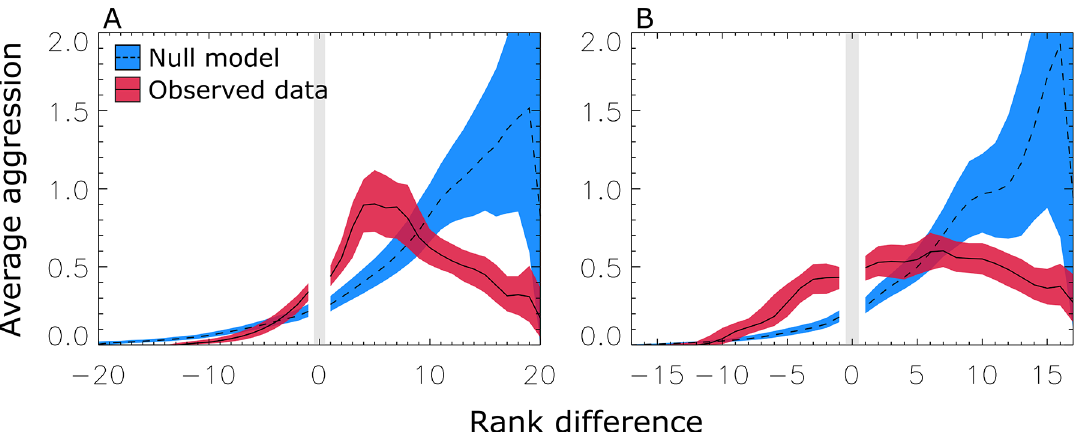
Fig 3. Structured aggression. Preferential rank aggression ( R ( Δ ), Eq 3) pooled over the final 3 quarters of the study period for Group One (a) and Group Two (b). Pooling data provides a gain of signal-to-noise that further refines our understanding of the strategies at work once the behavior-knowledge feedback is in place. Both groups show a focusing of aggression towards those nearby in rank, over and above null expectation. Higher levels of rank entrepreneurship — aggression directed, contrary to expectation, upwards in the hierarchy — are visible in Group Two. Points are averaged ± 1 rank; bands are 1 σ bootstrap-estimated error ranges.